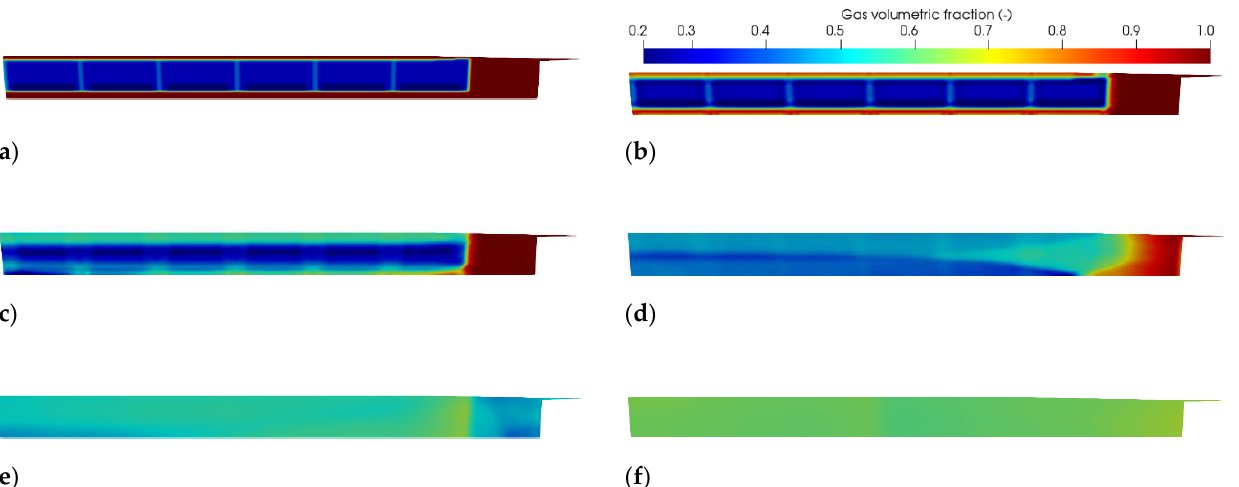
Figure 9. 2D Axisymmetric numerical results for 155/52 six-module charge firing test.